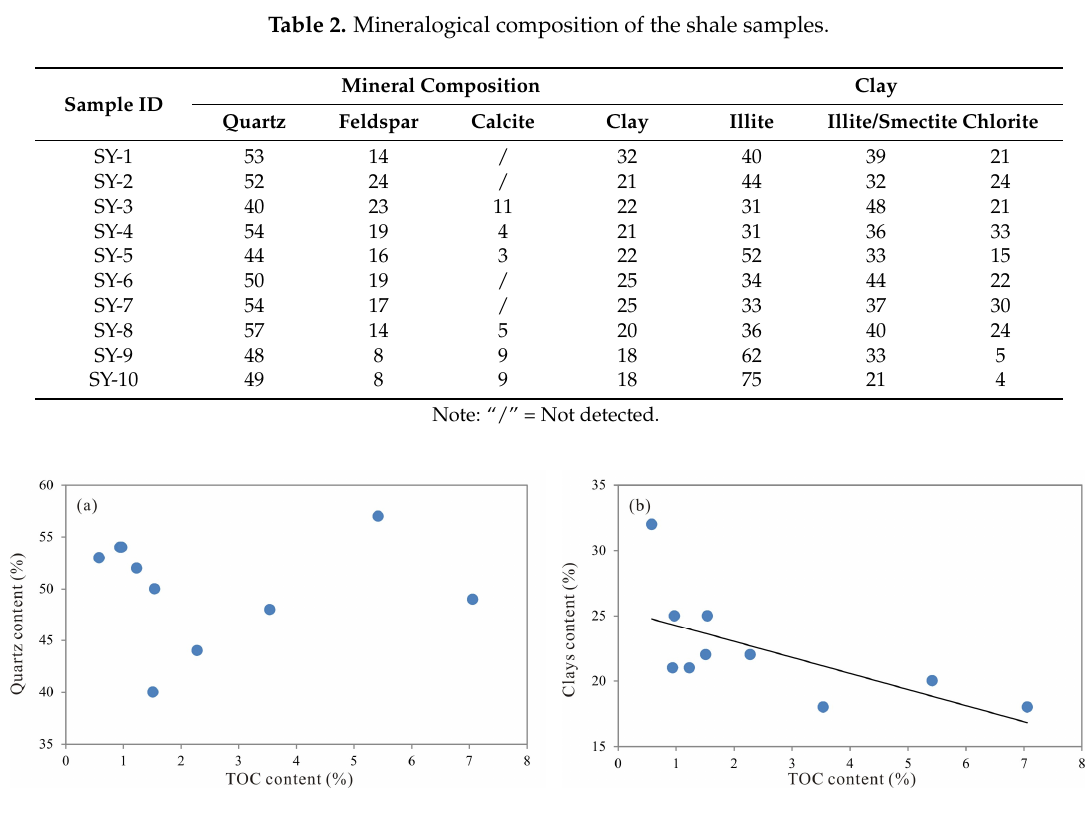
Figure 3. Relationships between total organic carbon (TOC) content and quartz content ( a ) and clay content ( b ). content ( b